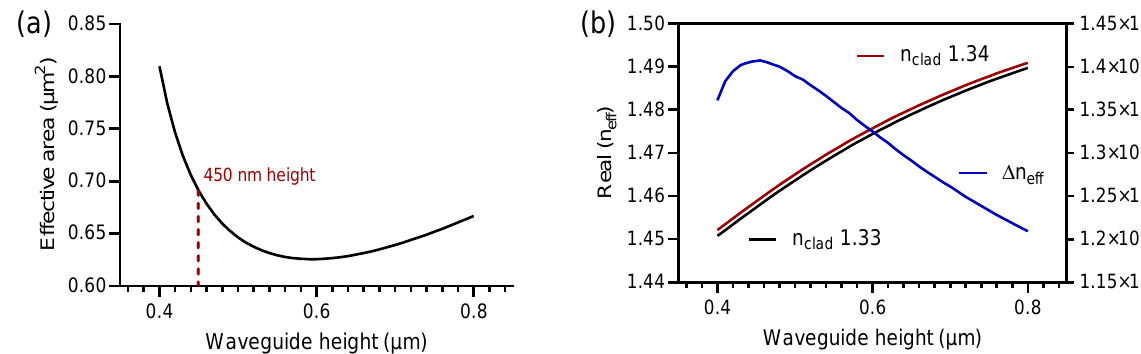
Figure 5. ( a ) Study of the behavior of the evanescent field, evaluating the effective area as a function of the height of the waveguide. ( b ) Analysis of the real part of the effective refractive index as a function of the height variation, for cladding values at 1.33 and 1.34, and the ∆ n ef f as a function of the reference